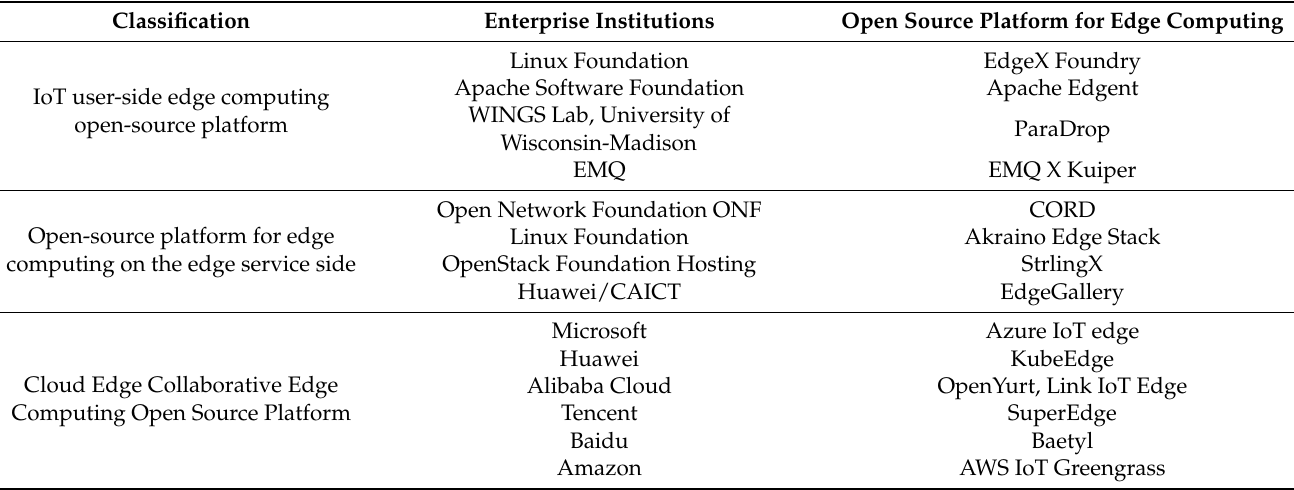
Table 3. Edge computing platform classification